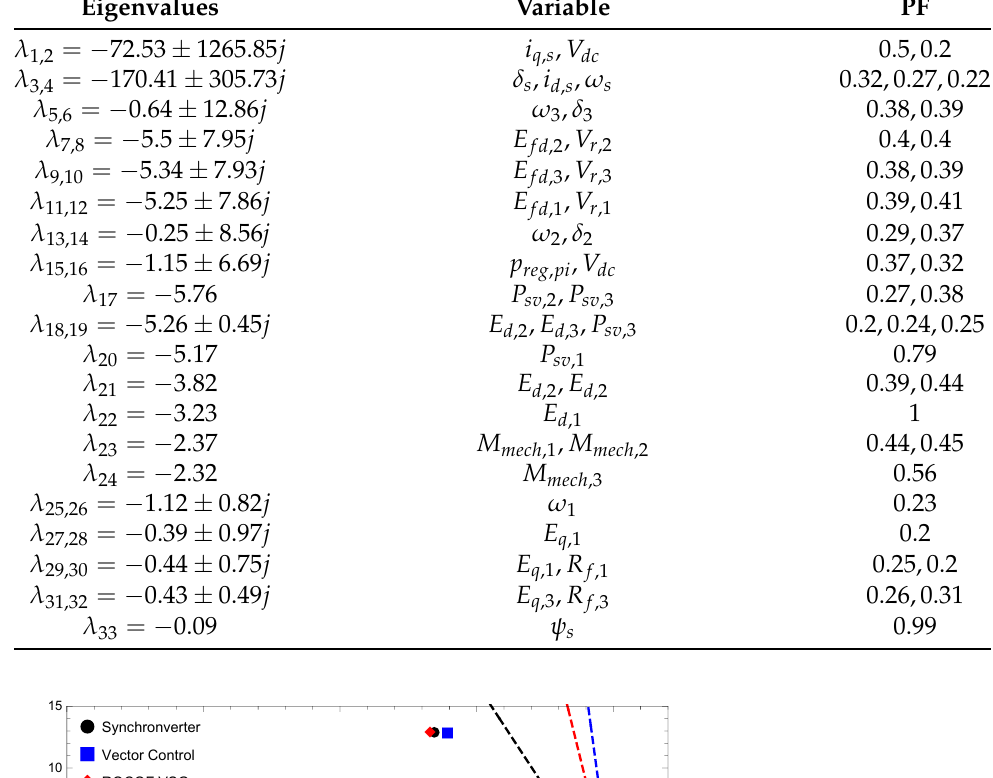
Table 1. The eigenvalues and participation factors of the system with synchronverters.